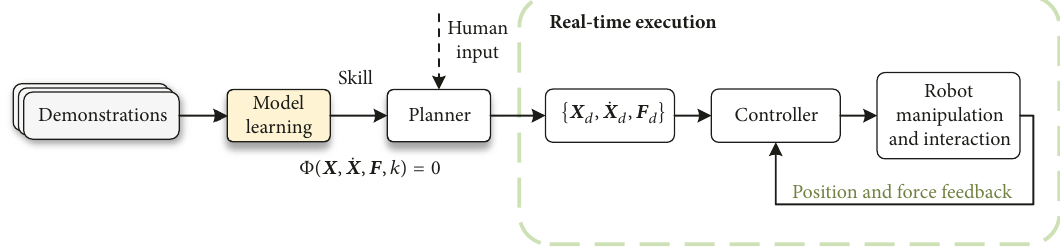
Figure 2: Framework of learning force-relevant skills.